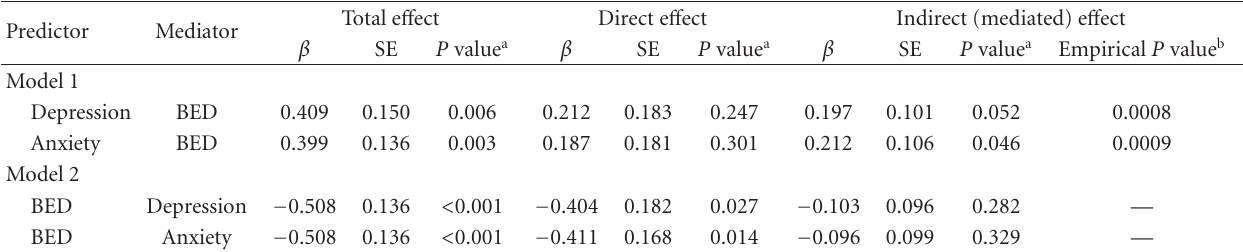
a Corresponding to the two-tailed test statistics for models run with sample data.